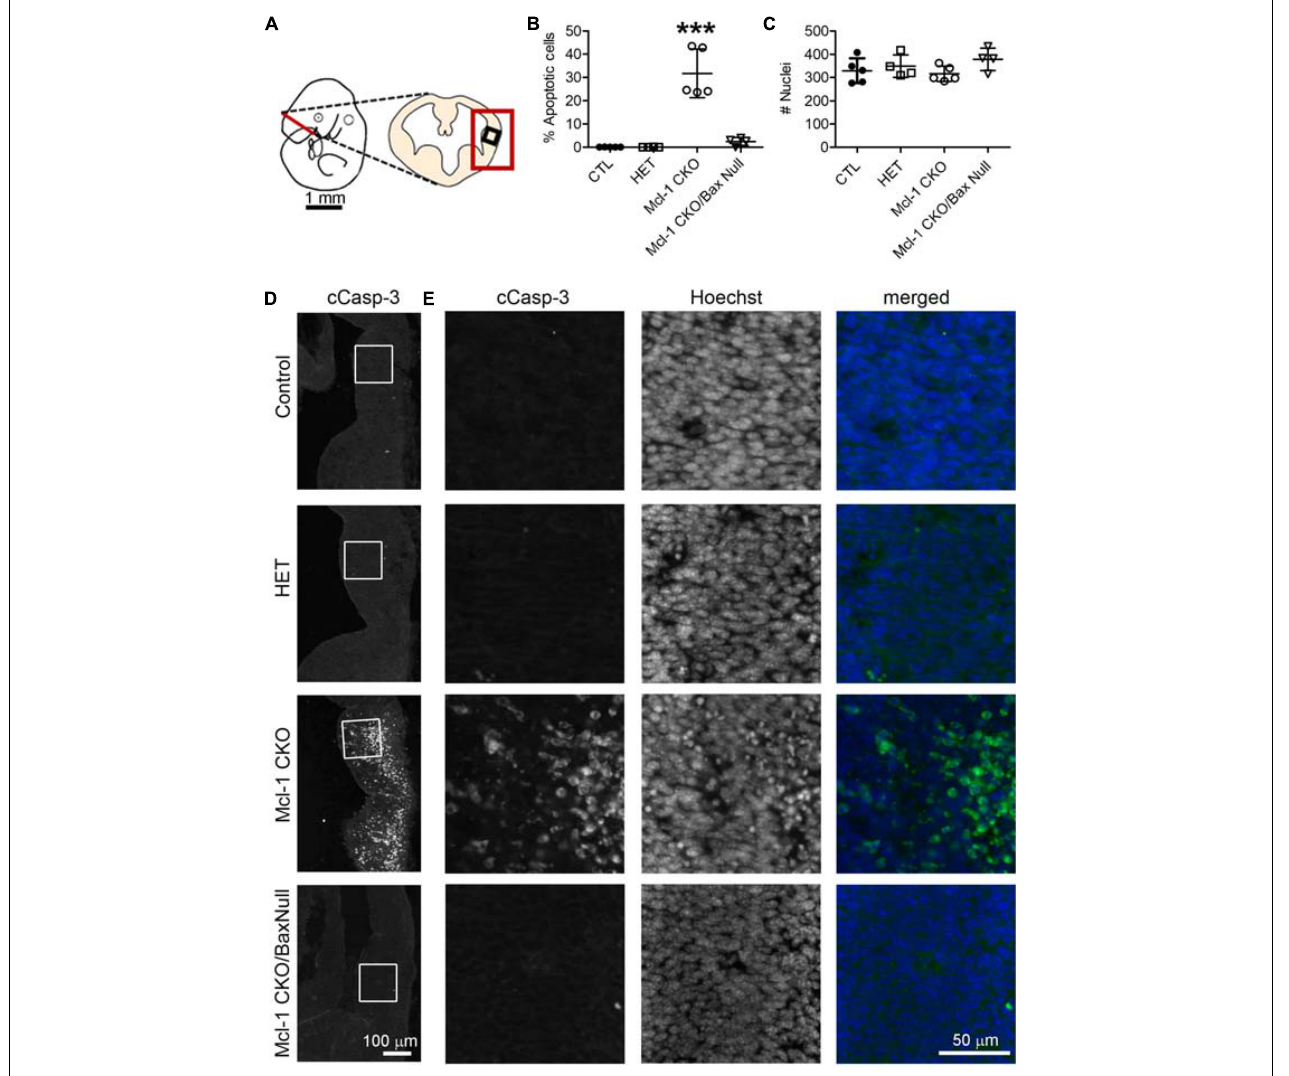
FIGURE 5 | Co-deletion of anti-apoptotic Mcl-1 and pro-apoptotic Bax rescued NPC from apoptosis at E11 in the ventral forebrain. (A) Line diagram of an E11 embryo showing a coronal section through the forebrain at the level of the lateral ganglionic eminence. Large red box depicts where representative images were taken in D and small black box identifies the area where counts were performed in E. (B) The number of cCasp-3 + cells were quantified within a 125 µ m × 125 µ m area (boxed area in D, E) and represented as a percentage of the total number of Hoechst + nuclei. There were significantly more apoptotic cells in the Mcl-1 CKO forebrains and this was largely rescued in the Mcl-1 CKO/Bax null forebrain. (C) A comparison of the total number of Hoechst + nuclei revealed no significant differences across the genotypes. A one-way ANOVA was performed on the means followed by Tukey’s multiple comparison test. CTL ( n = 5), Mcl-1 CKO ( n = 5), Mcl-1 CKO/BaxNull ( n = 4). (D) Representative sections through the ventral forebrain of E11 control, Mcl-1 CKO and Mcl-1 CKO/BaxNull embryos. (E) Higher magnification of boxed areas in D showing individual panels for cCasp-3 immunostaining, Hoechst and merged (cCasp-3 = green, Hoechst = blue). *** p < 0.001 , error bars represent ±